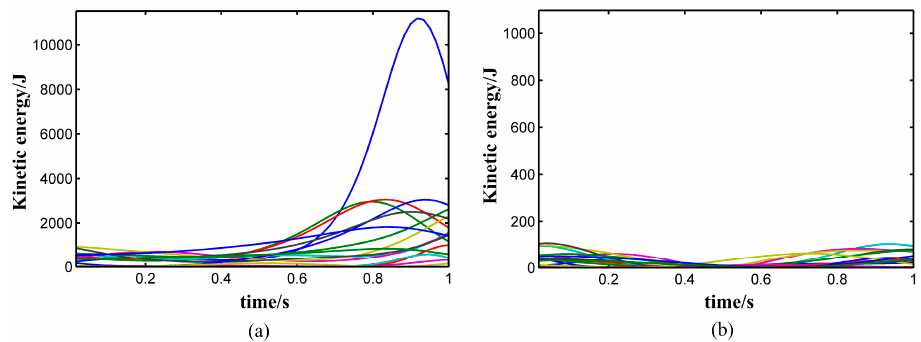
Figure 6. Generator kinetic energy of 16 ‐ machine 68 ‐ bus system: ( a ) unstable case; and ( b ) stable case.